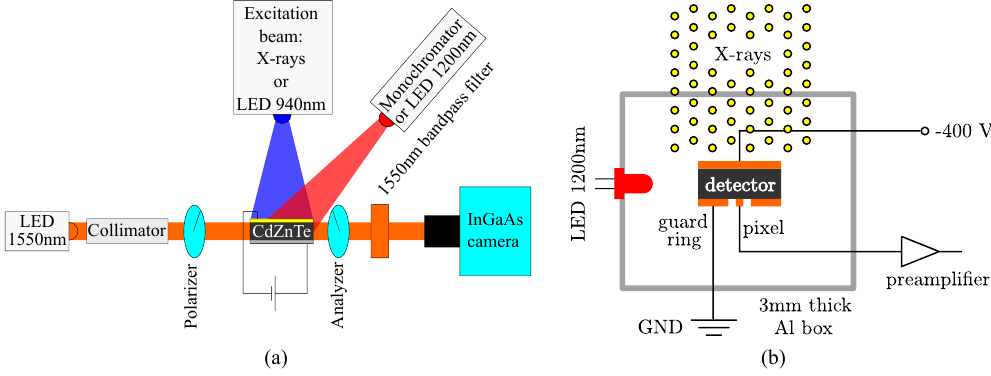
Figure 1. Experimental setup for Pockels effect measurements performed on Sample 1 ( a ). During standard electric field measurements, the cathode of the sample was irradiated by X-rays and simultaneously illuminated from the side by a 1200-nm LED during de-polarization mode. During the infrared spectral scanning (IRSS) measurements, the cathode was illuminated by a 940-nm LED and by tunable light from the monochromator from the side. The experimental setup used for X-rays measurements on Sample 2 ( b ). The planar cathode (top) was irradiated by X-rays. The pixel with a 0.5-mm diameter was surrounded by a guard ring covering the rest of the anode side